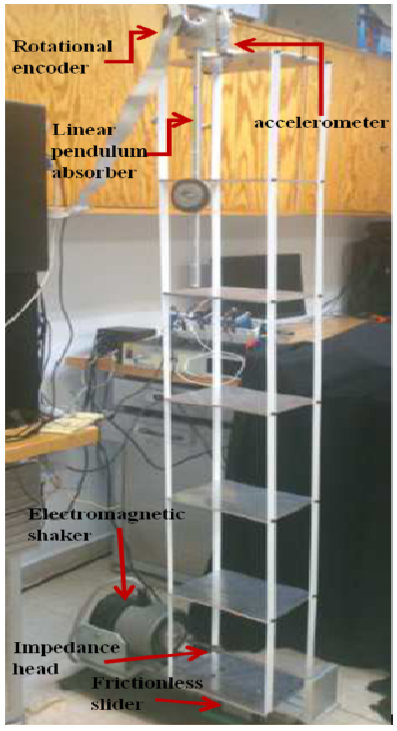
Figure 3. Experimental setup of the main system with a linear pendulum vibration